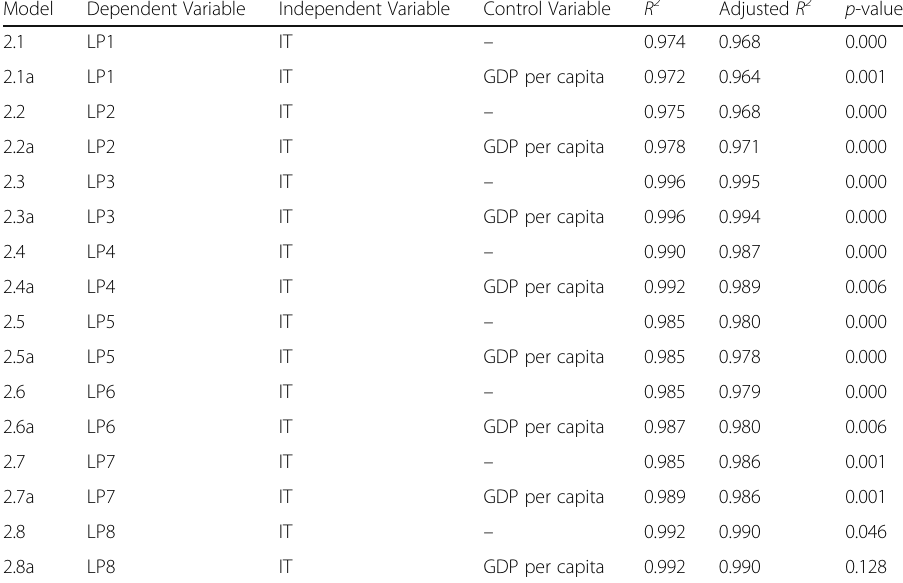
Table 3 Regression Results of Hypothesis